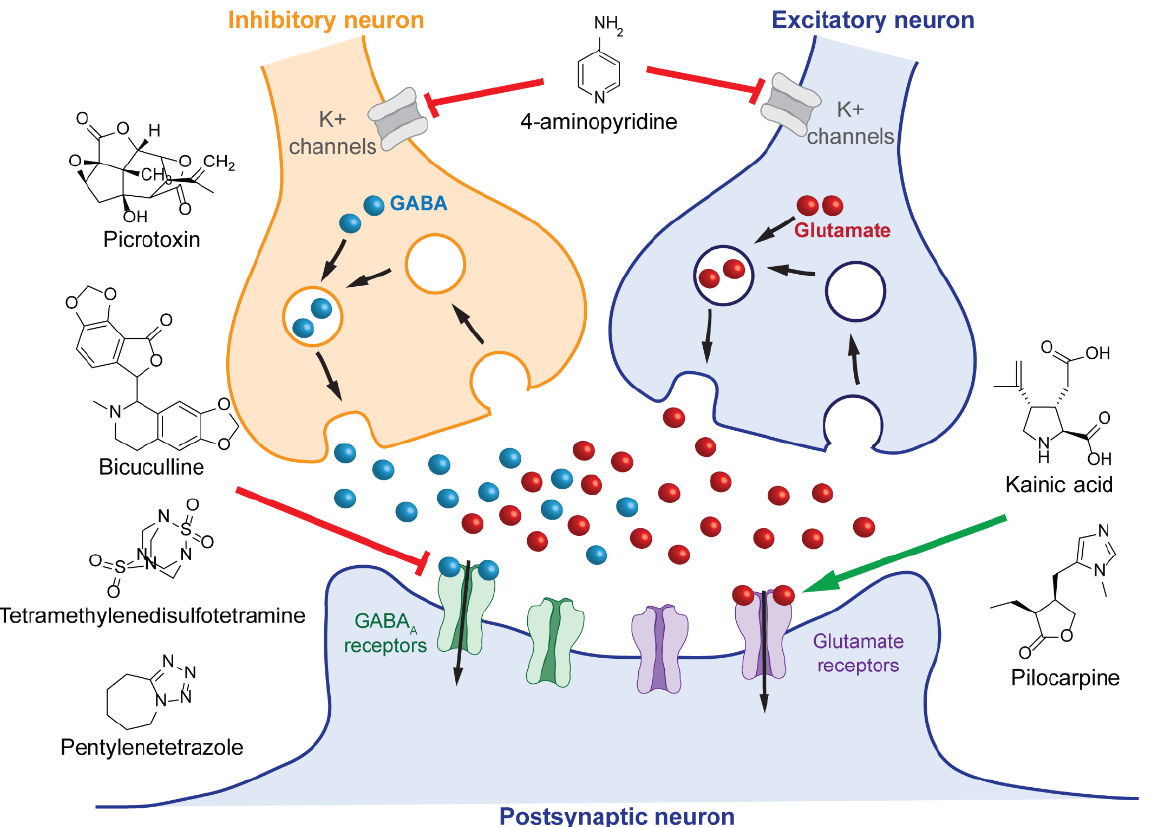
Figure 2. Simplified schematic of chemical inducing agents used to model seizures in aquatic verte- brates.